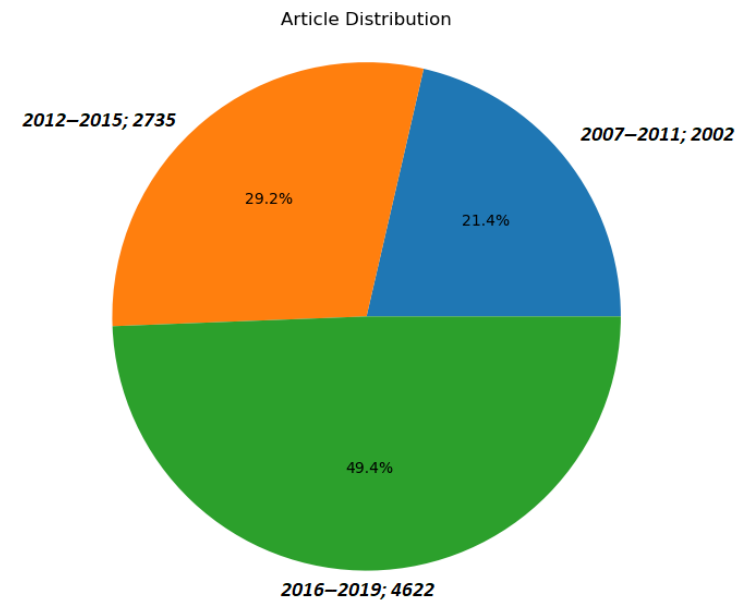
Figure 4. The distribution of research articles among the three time